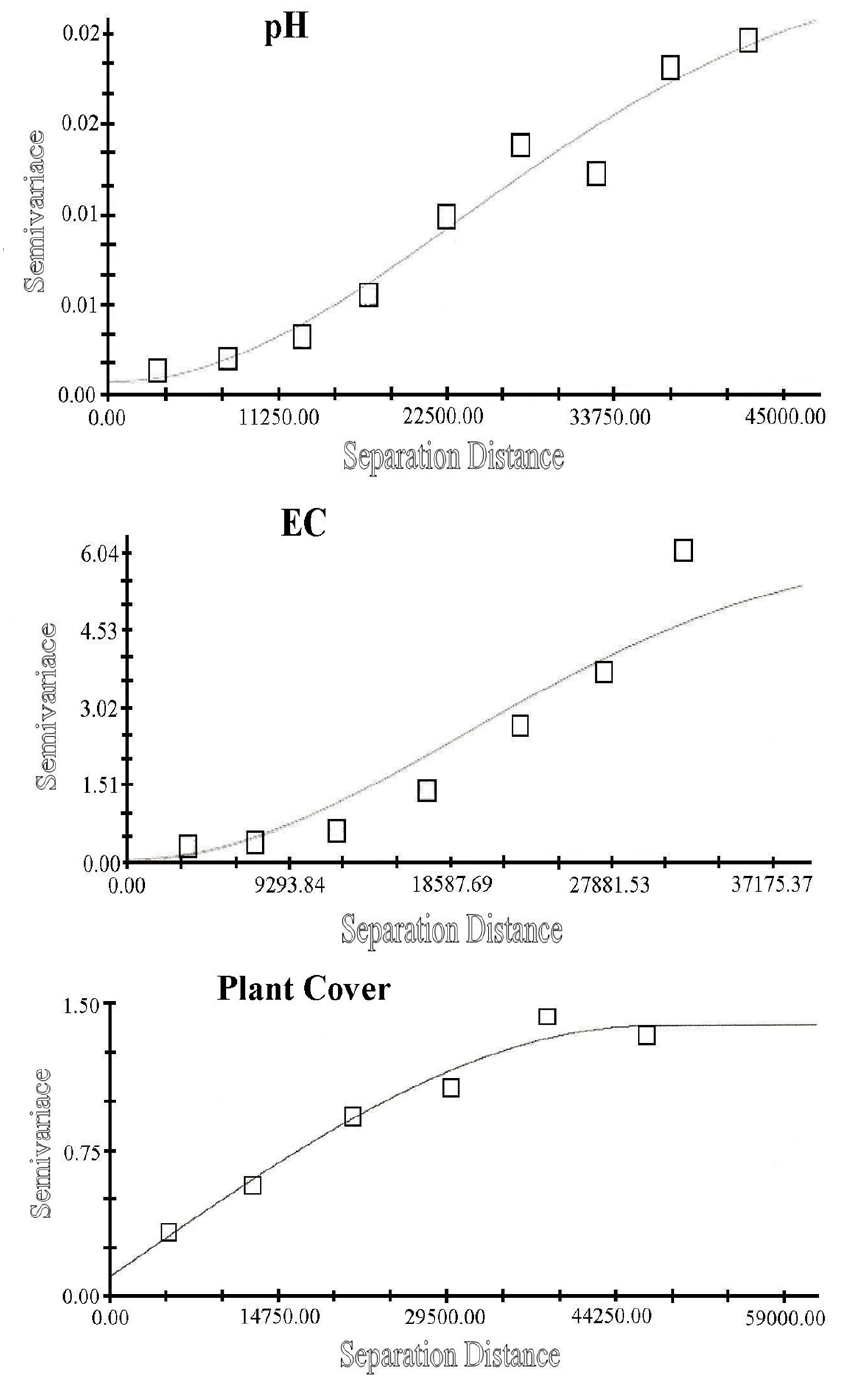
Fig. 2. Variograms related to different factors in kriging